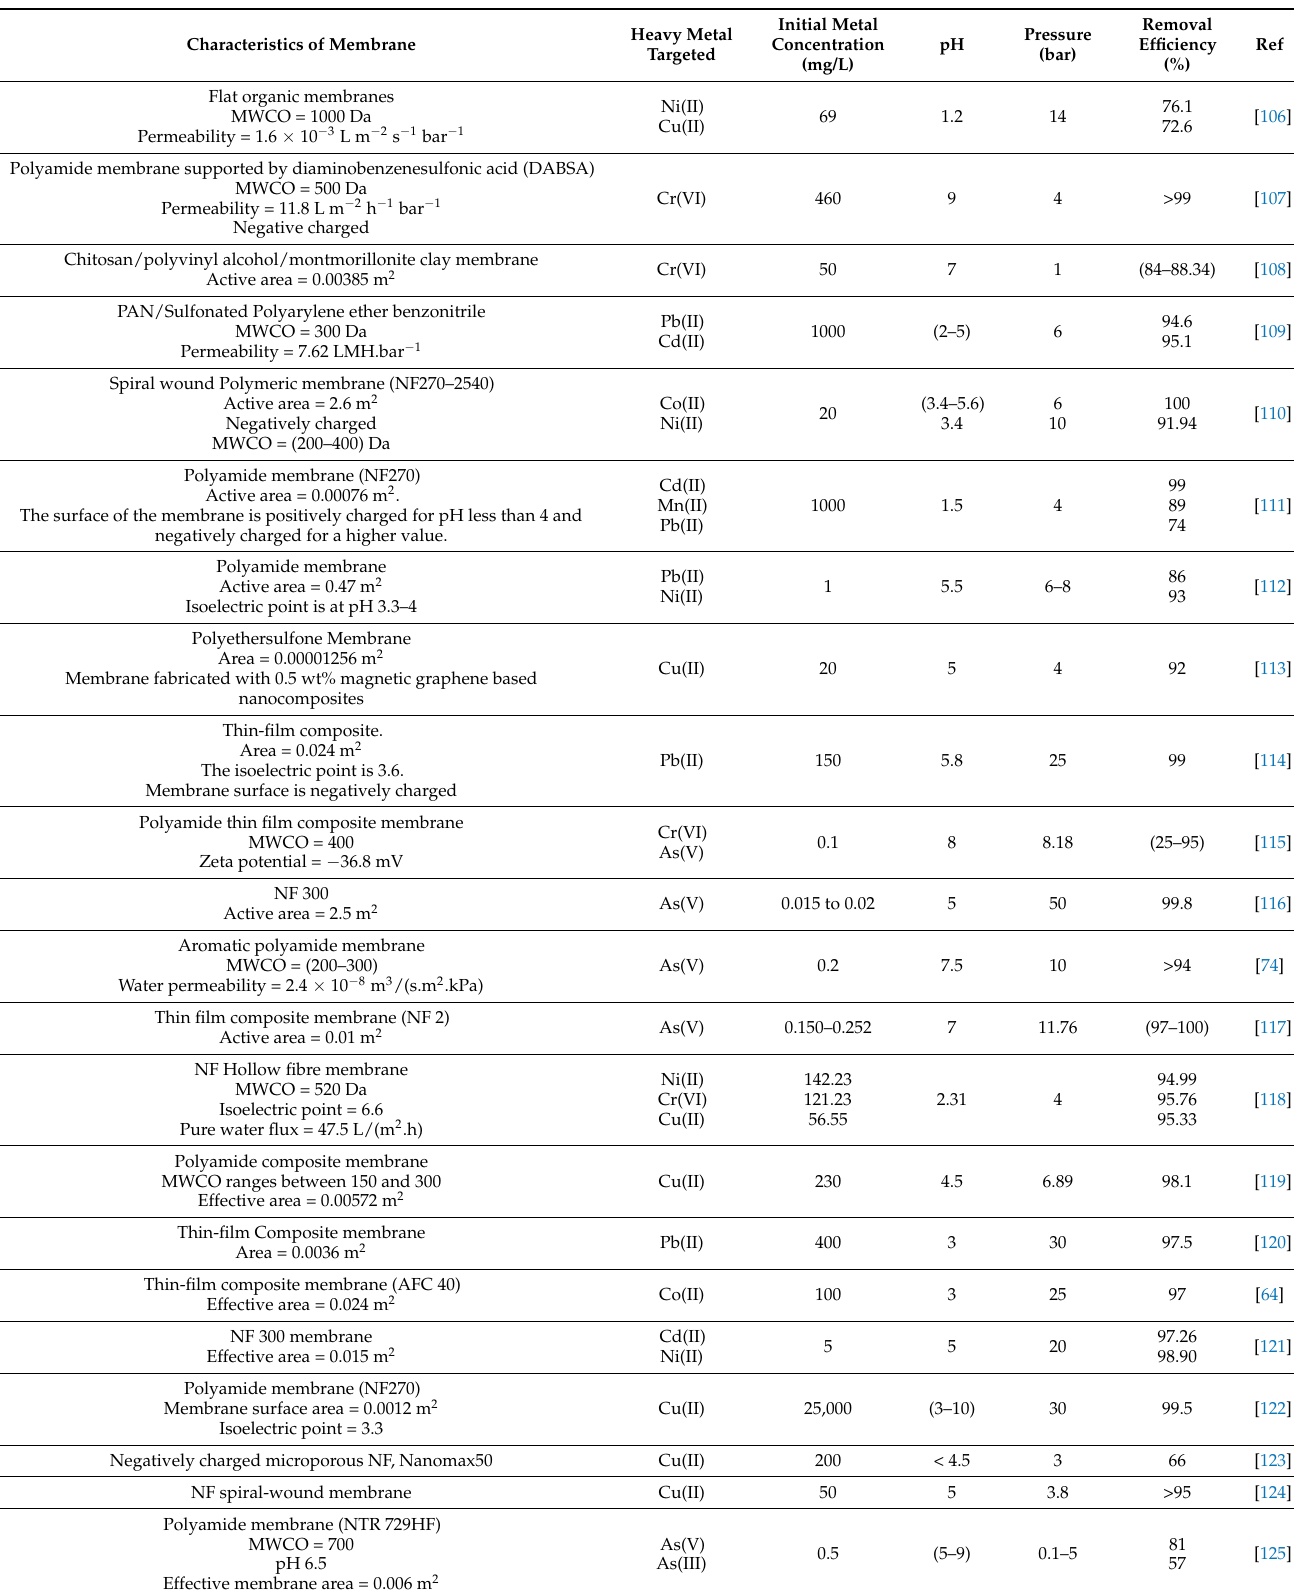
Table 3. Review of literature concerning application of NF in heavy metal removal. Characteristics of